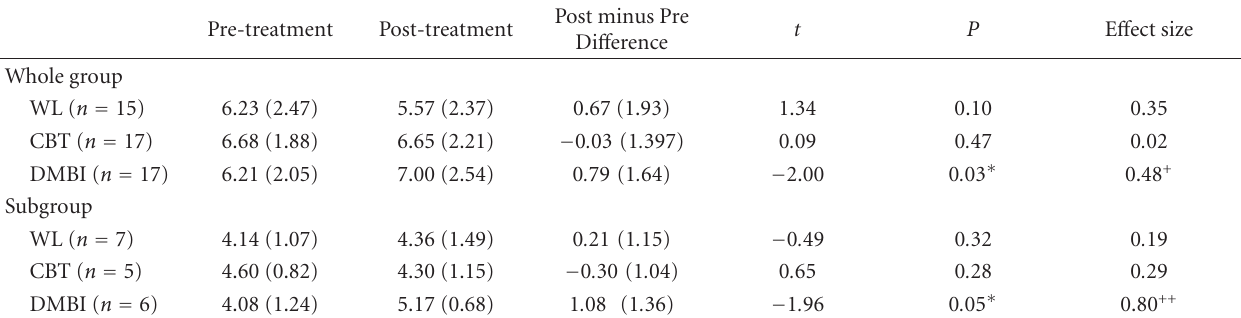
Table 3: Total sleep time (hours) at pre- and